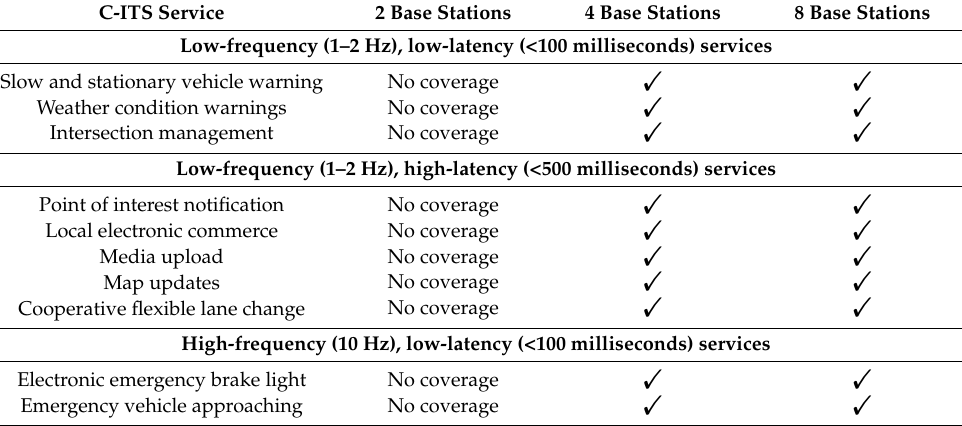
Table 7. Communication requirements of common C-ITS services and their fulfillment by 5G-based C-V2X in the infrastructural mode and investigated context. Adapted and updated from [39].